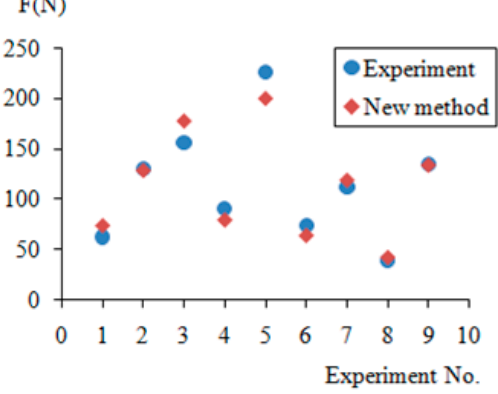
Figure 10. Results of predicted cutting force with new proposal method and in comparison with the experiment.